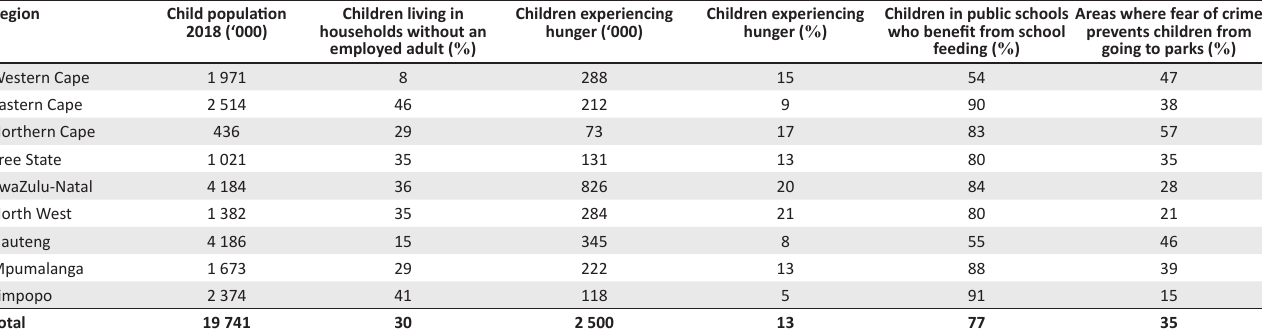
TABLE 1: Children who live in households with no employed adults, who experience hunger or who live in areas where crime prevents them from using parks, 2018. Region Child population 2018